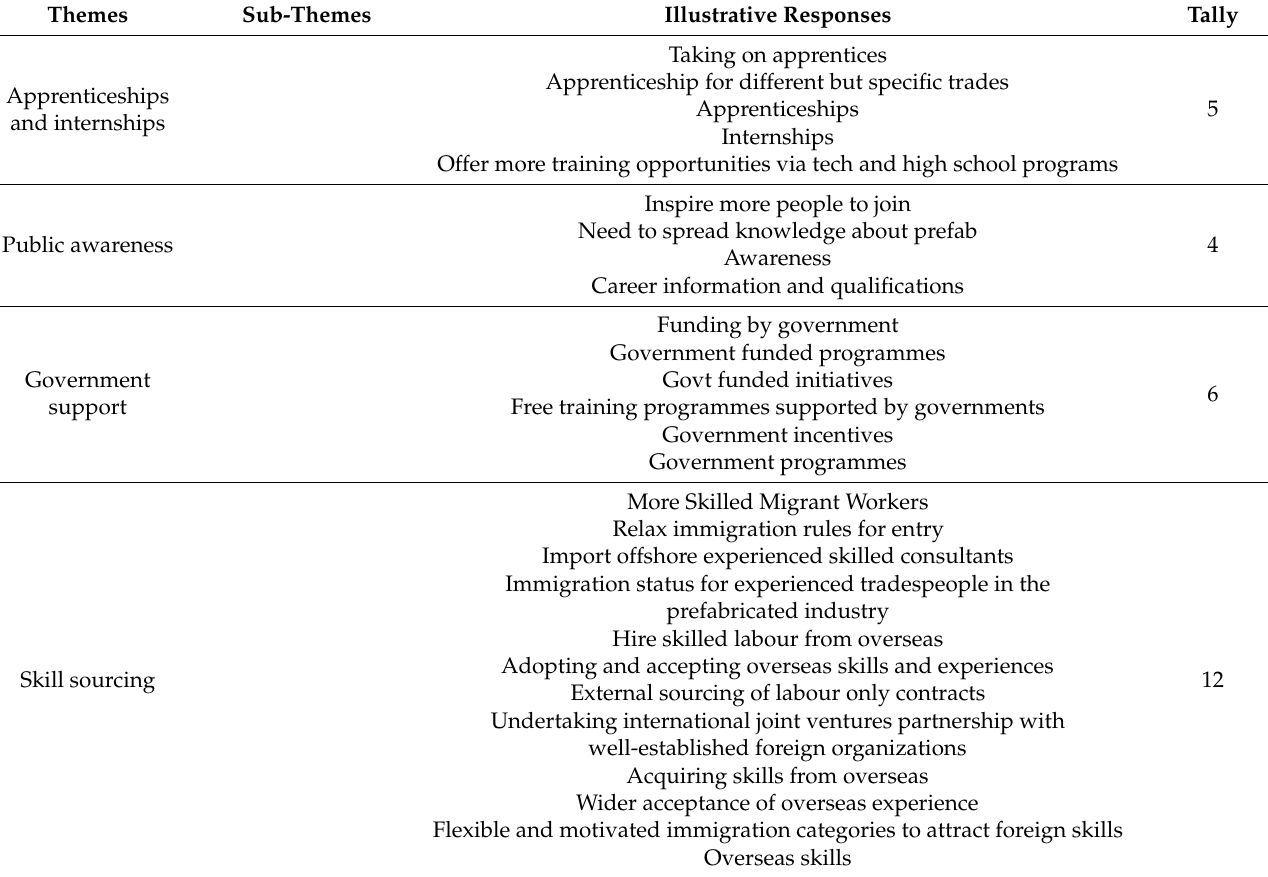
Table 7. Suggestions for improving the skill shortage issues in the prefabrication supply